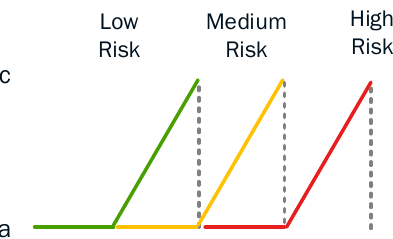
Figure 13. An example of the semi-triangular membership function.